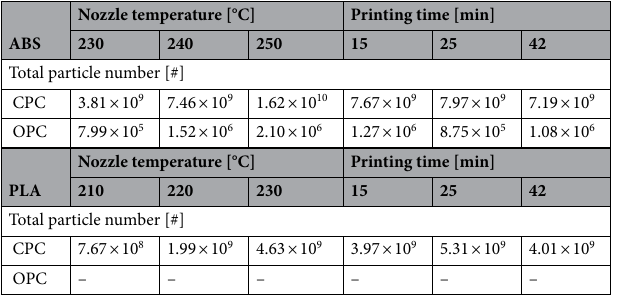
Table 3. Summary of total particle number for different nozzle temperatures and printing times for ABS and PLA